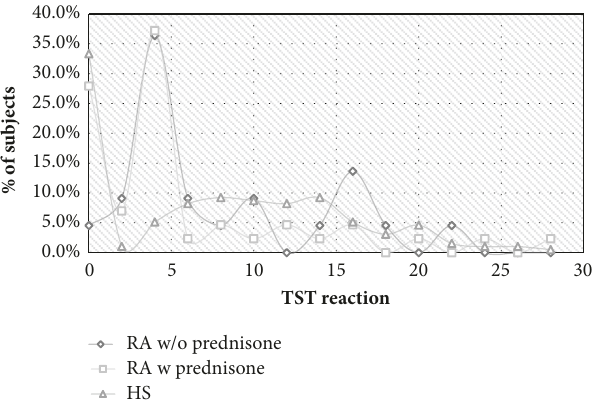
Figure 1: TST reactions in RA patients treated with prednisone, in those not treated with prednisone and in controls. TST = tuberculin skin test; RA = rheumatoid arthritis; HS = healthy